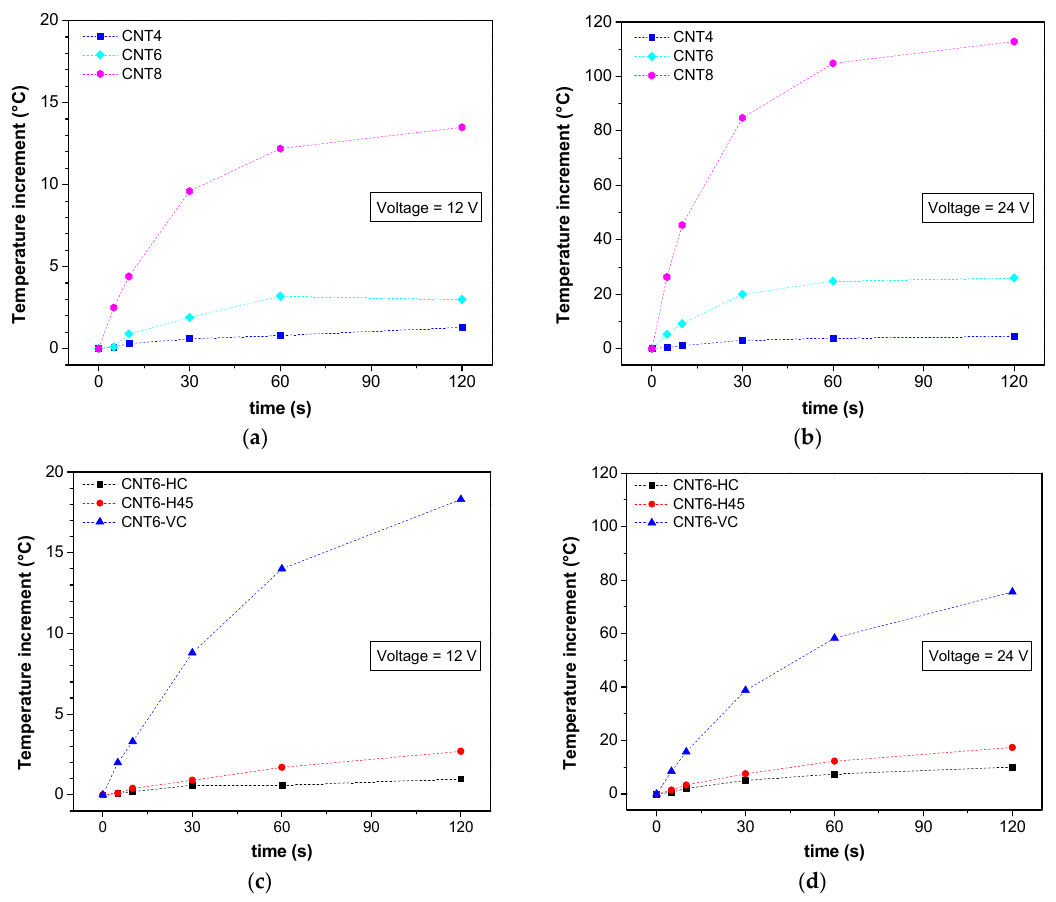
Figure 16. Increment of surface temperature upon a voltage of 12 V ( a , c ) and 24 V ( b , d ) for ABS nanocomposites filaments and 3D-printed samples with different CNT loading at room temperature of 23 °C.